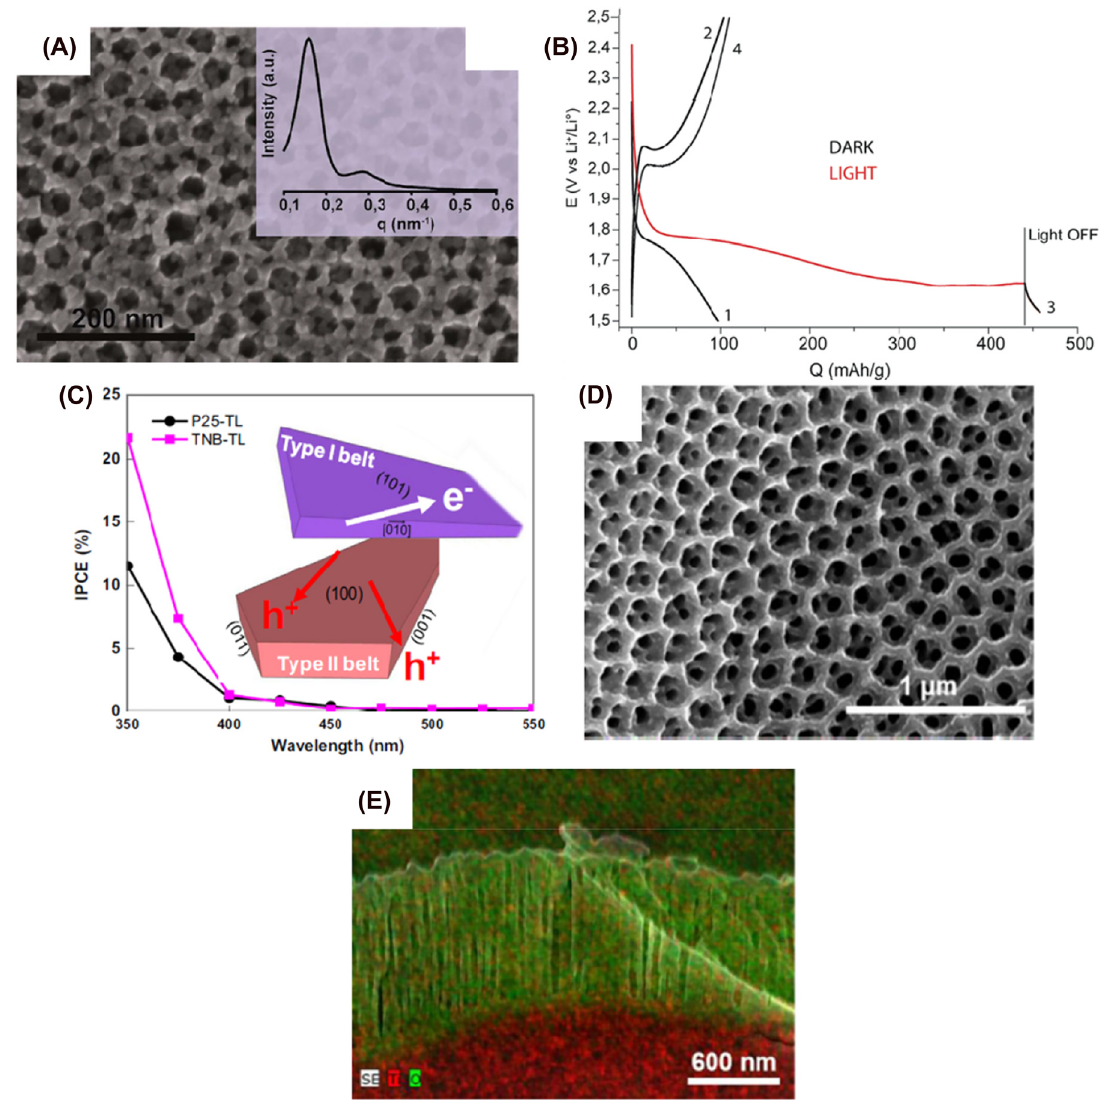
Figure 4: Structure and performance of titanium oxide-based photoelectrodes. (A)SEM-FEGimageofthetopofthemesoporousTiO 2 fi lm.Theinsetcorrespondstograzing-incidencesmall-angleX-rayscatteringscanofthe fi lm.(B)